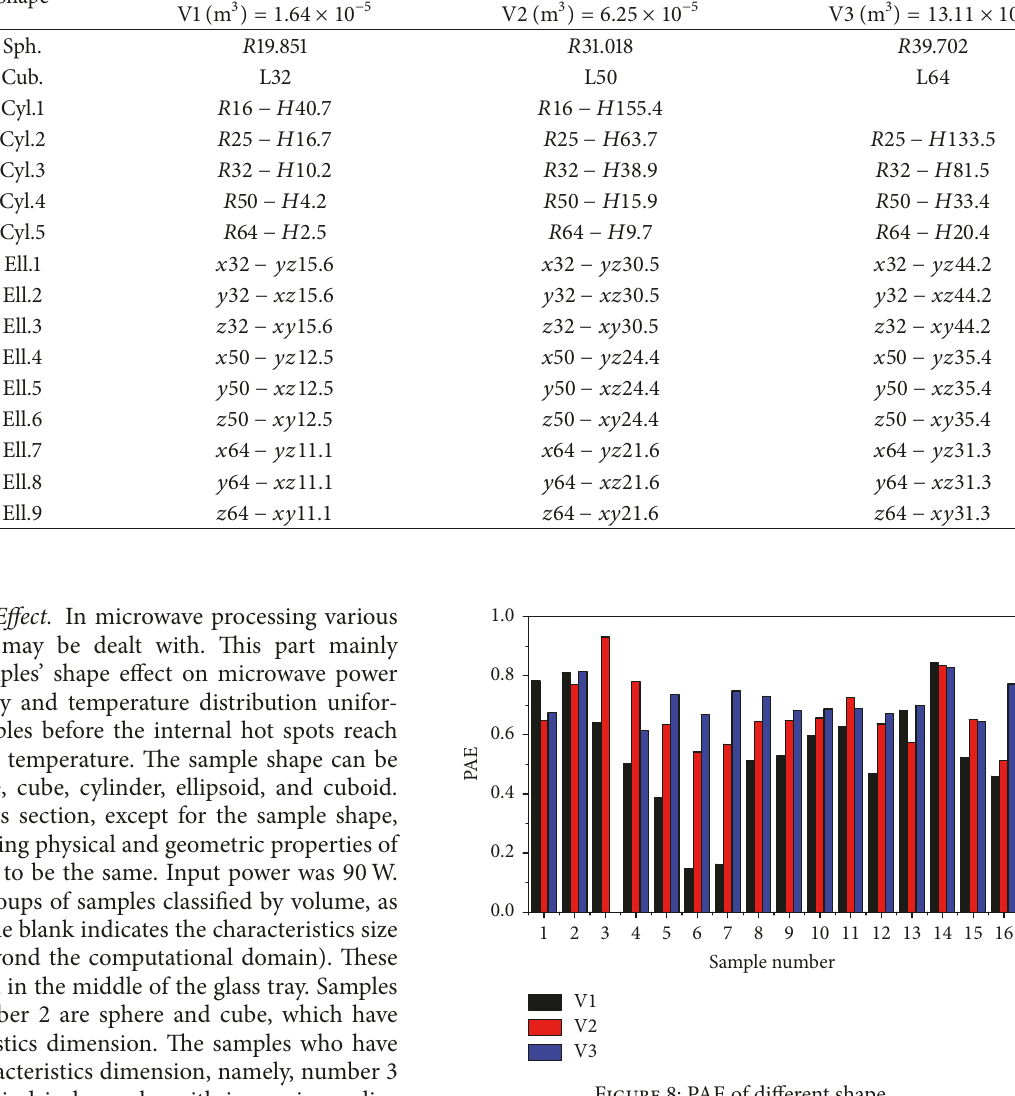
Figure 8: PAE of different shape.